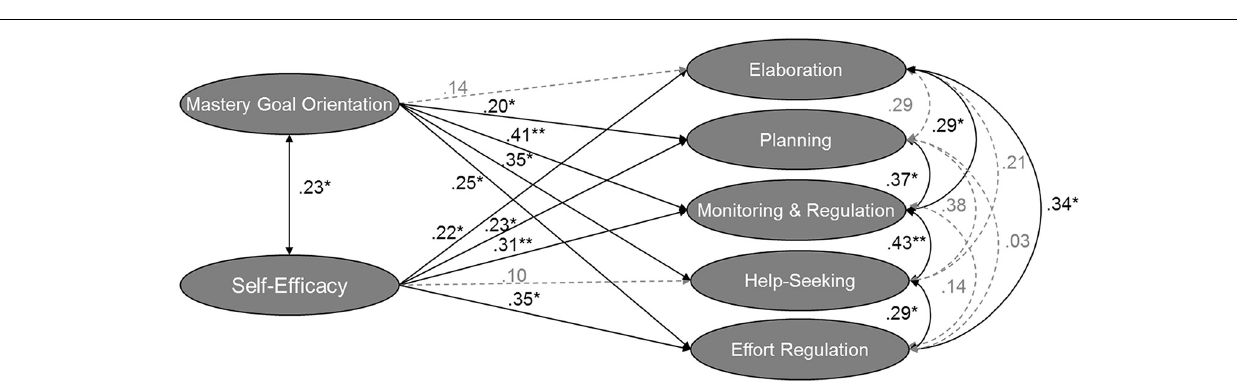
FIGURE 2 | Structural equation model showing the relations of self-efficacy and mastery-approach goal orientation to correlated SRL strategies. Coefficient is significant at the 0.05 level *, at the 0.01 level **. Paths which are n.s. are gray colored. N = 170. The model fit is χ 2 (329) = 387.514, CFI = 0.940, RMSEA (90% CI) = 0.032 [0.016; 0.044], SRMR =